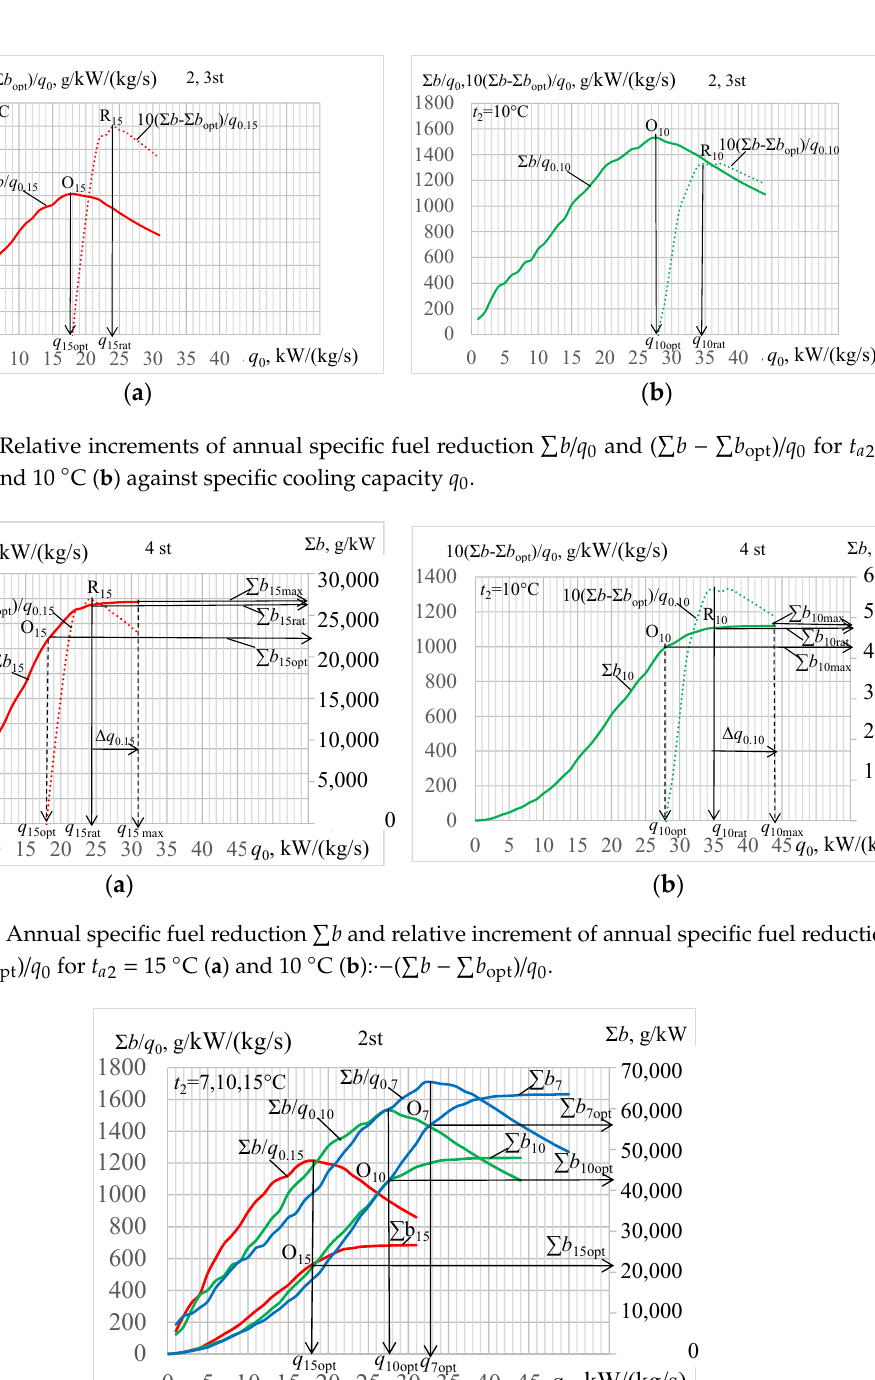
(cid:80) b / q 0 and annual specific fuel reduction